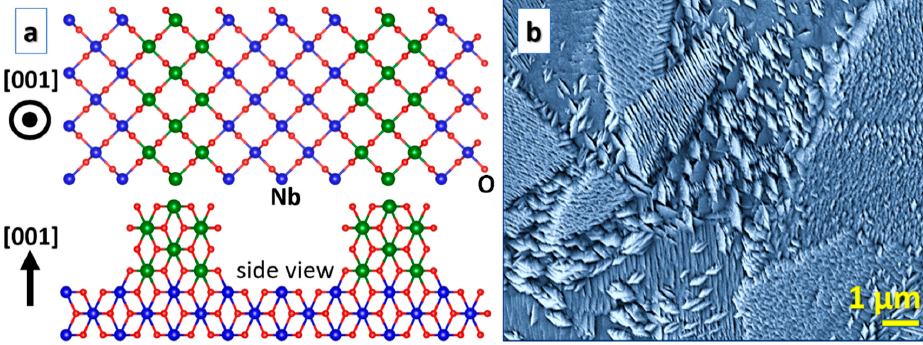
Figure 4. NbO 2 nanoslices: ( a ) A theoretical model; ( b ) a secondary electron microscopy image of a corresponding sample (a micrograph of an equivalent sample published in the literature [22]).